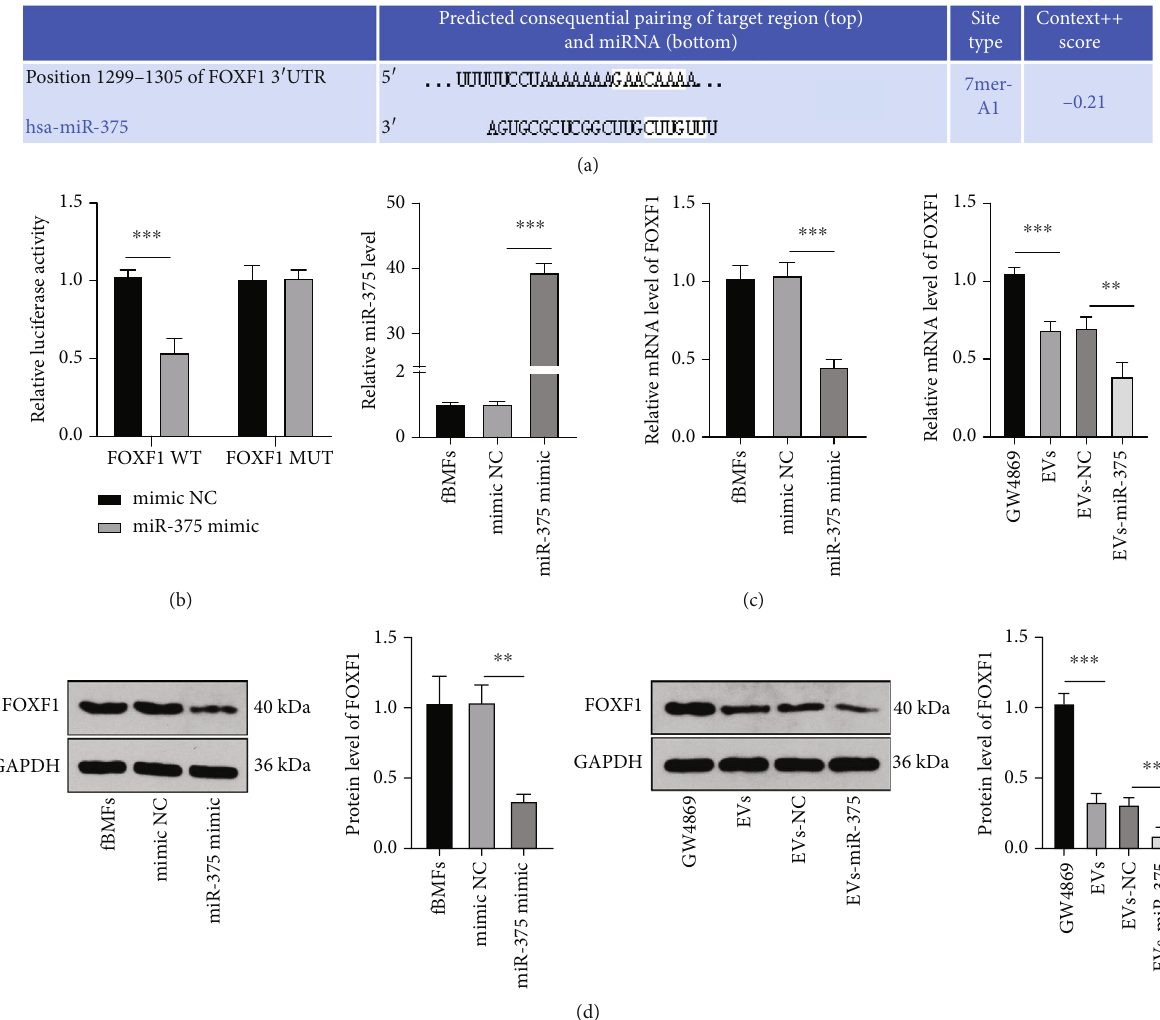
Figure 5: miR-375 targets FOXF1 in fBMFs. (a) The binding sites of miR-375 and FOXF1 were analyzed. (b) Dual-luciferase reporter gene assay was used to detect the binding relationship between miR-375 and FOXF1. (c, d) The expression of FOXF1 in each group was detected using RT-qPCR and WB. The experiment was repeated 3 times, and the data were expressed as mean ± SD . Comparison among groups was analyzed using one-way ANOVA, followed by Tukey ’ s multiple comparisons test. ∗∗ P < 0 : 01 and ∗∗∗ P < 0 : 001